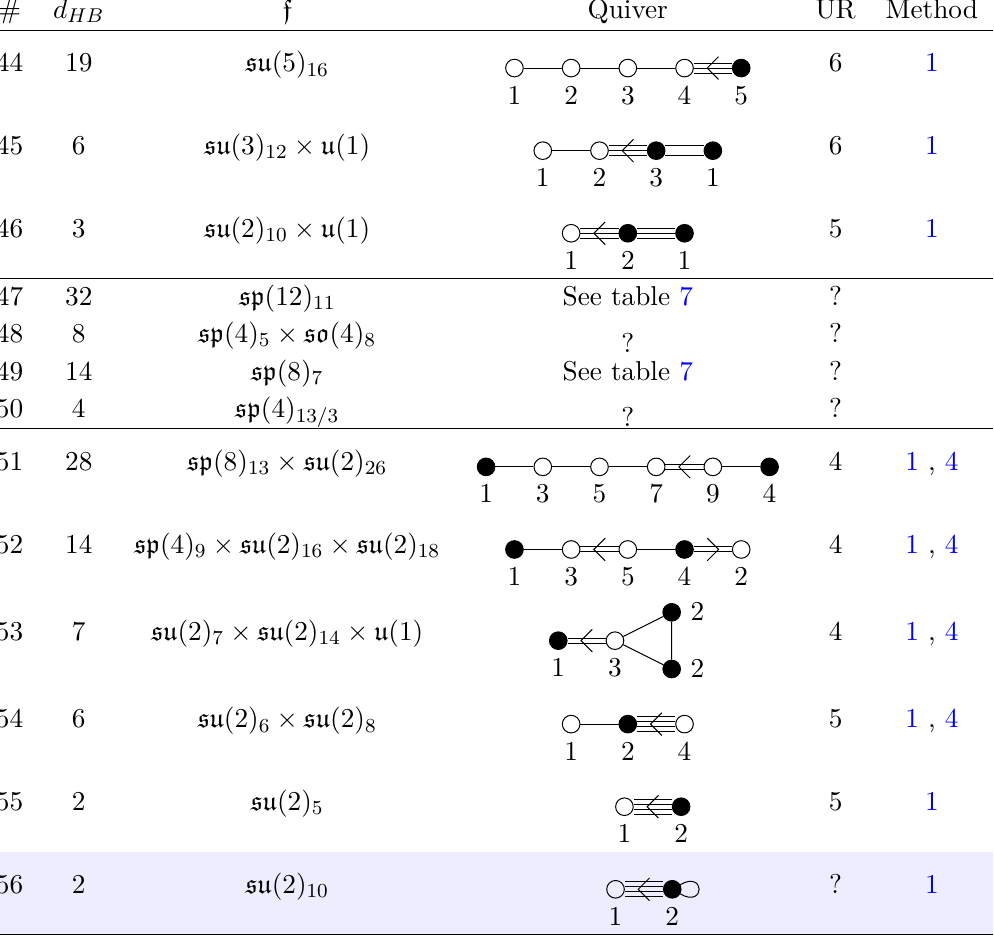
Table 5 . List of magnetic quivers (continued). Lines shaded in blue correspond to 4d